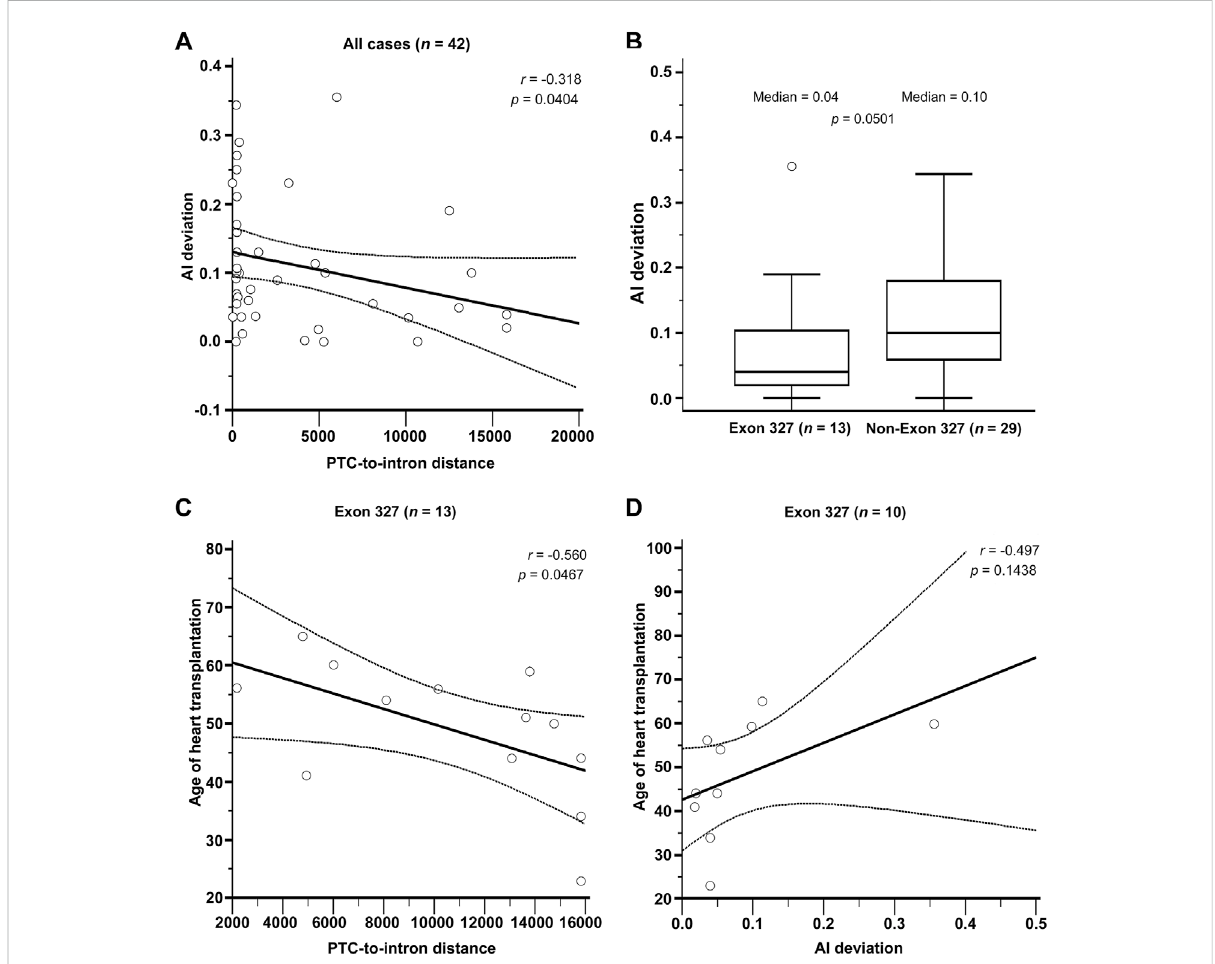
FIGURE 3 (A) RelationshipbetweenPrematureterminationcodon(PTC)-to-introndistanceandallelicimbalancedeviation(AIdeviation). (B) Differencein nonsense-mediated mRNA decay ef fi ciency measured by AI deviation level between exon 327 and non-exon 327 titin-truncating variants (TTNtvs). Median PTC-to-intron distance was 10,693 and 223 in exon 327 group and non-exon 327 TTNtvs, respectively ( p < .001). (C) Relationship between PTC-to-intron distance and age of heart transplantation in carriers of exon 327 TTNtv. (D) Relationship between AI deviation and age of heart transplantation incarriers ofexon 327TTNtvs. p -values are from Pearson ’ scorrelation testand the Mann – Whitney test. PTC, premature termination codon; AI, allelic imbalance; TTNtv, titin-truncating